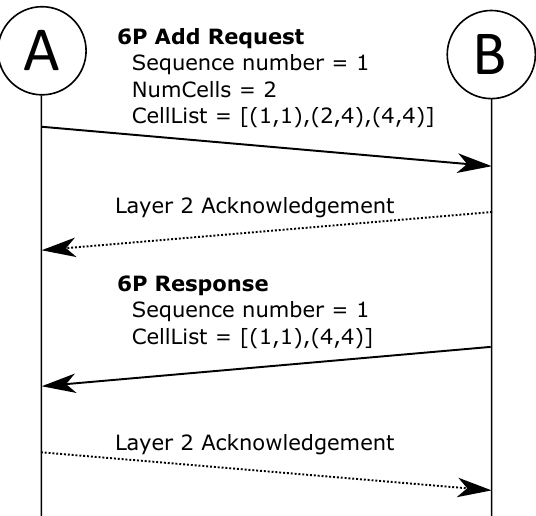
Figure 4. Simplified example of 6P Add transaction between node A and